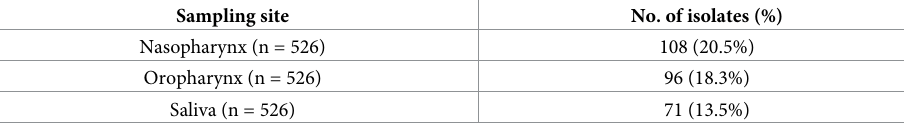
Table 2. Detection of S . aureus according to the sampling site.